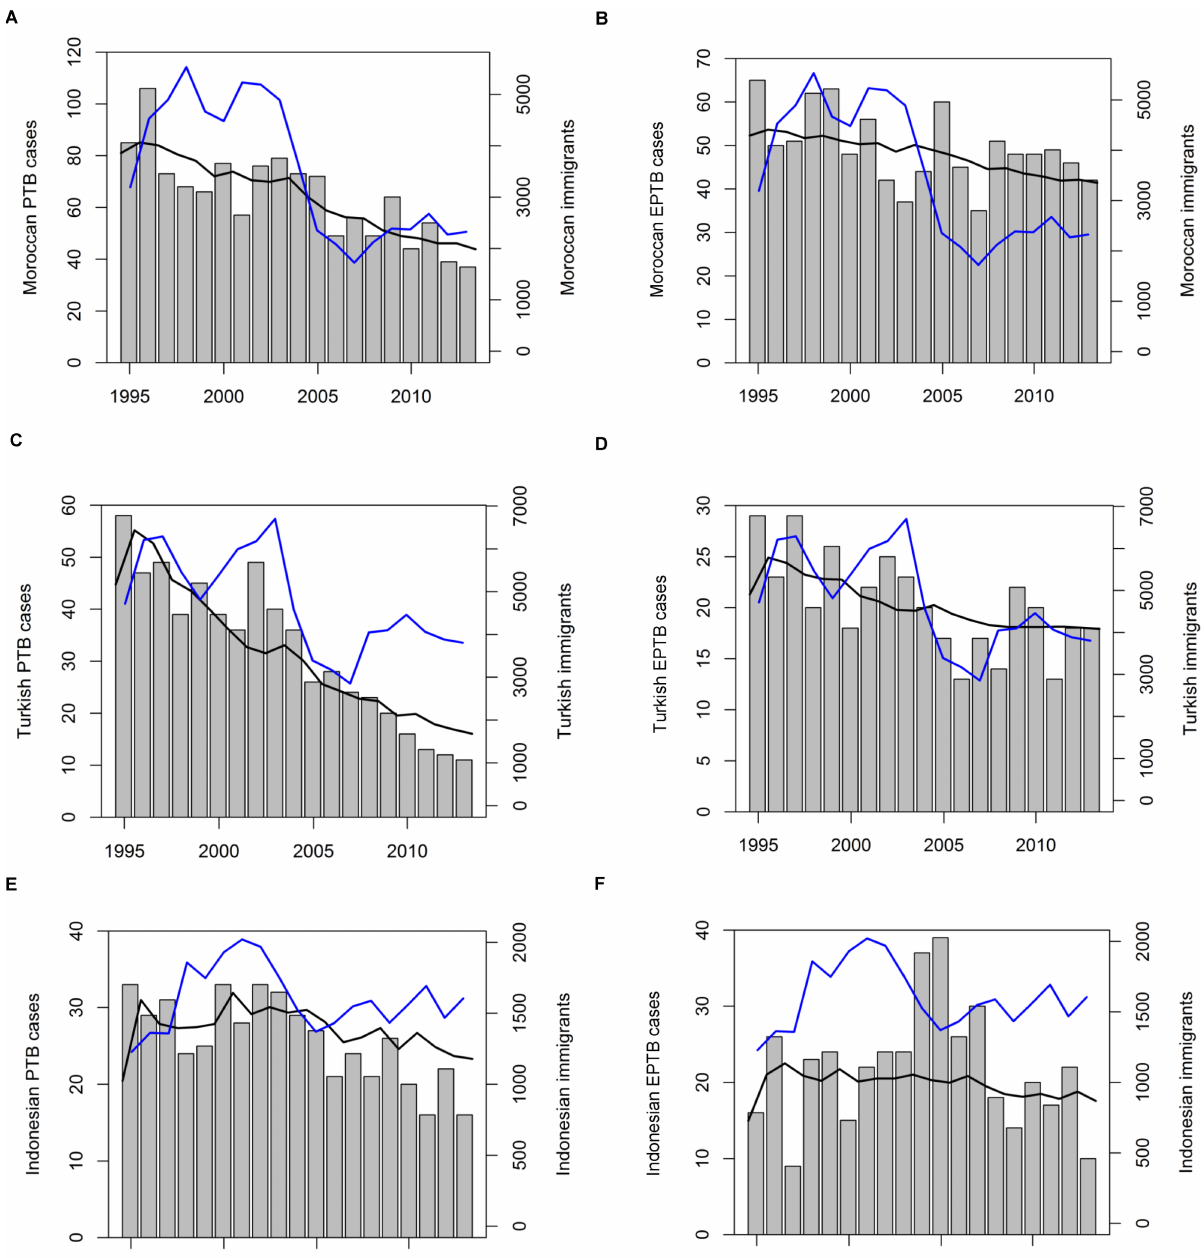
Fig 2. Best fit model to diagnosed (E)PTB cases. Number of diagnosed (A) PTB and (B) EPTB cases among Moroccan-born (grey bars; left axis). The black line represents the best-fit line to the diagnosed cases (left axis), the blue line represents yearly immigration figures from Morocco (right axis). Turkish-born (C) PTB, (D) EPTB cases, and Indonesian-born (E) PTB, (F) EPTB